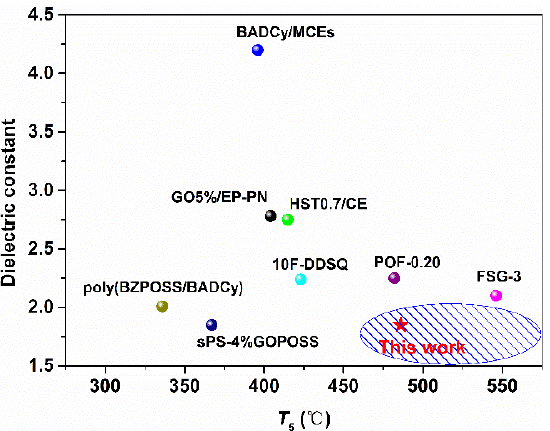
Figure 9. The dielectric constant for PBDP/HGM-NH 2 composites in this work and other polymer composites reported in the literature vs. thermal decomposition temperature.